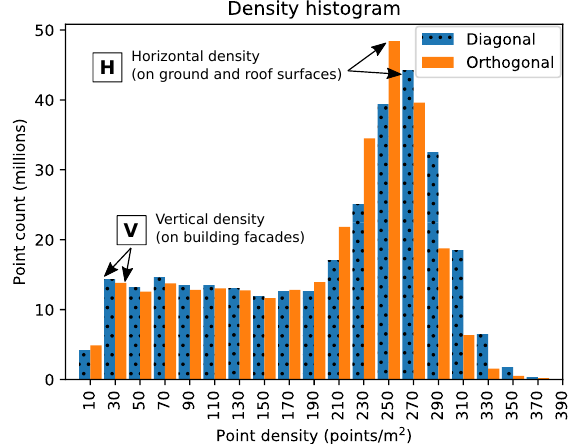
Figure 10. Density histograms of the complete Diagonal and Orthogonal point clouds, where the Diagonal point cloud has a higher number of high-density